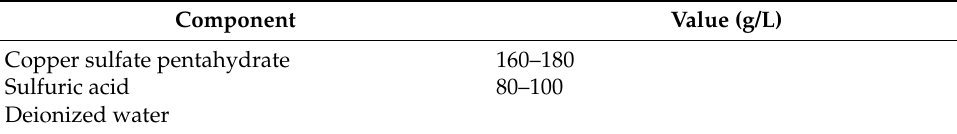
Table 2. Composition of the solution for copper